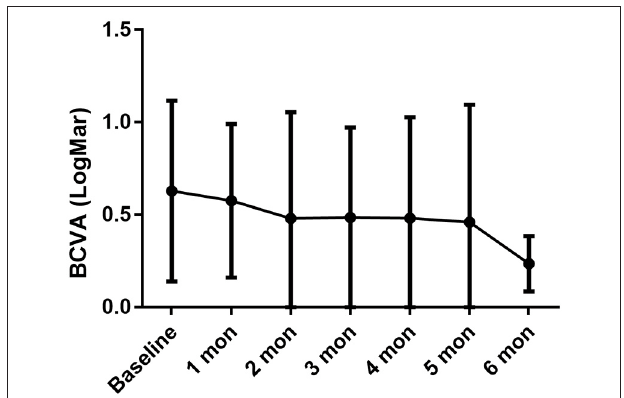
FIGURE 1 | BCVA persistently increased during the treatment period, with baseline LogMar BCVA 0.63 ± 0.49, 0.58 ± 0.41 in 1-month ( P = 0.033 compared with baseline), 0.48 ± 0.57 in 2-month ( P = 0.057), 0.49 ± 0.49 in 3-month ( P = 0.029), 0.48 ± 0.54 in 4-month ( P = 0.017), 0.46 ± 0.63 in 5-month ( P = 0.192), 0.24 ± 0.15 in 6-month ( P =